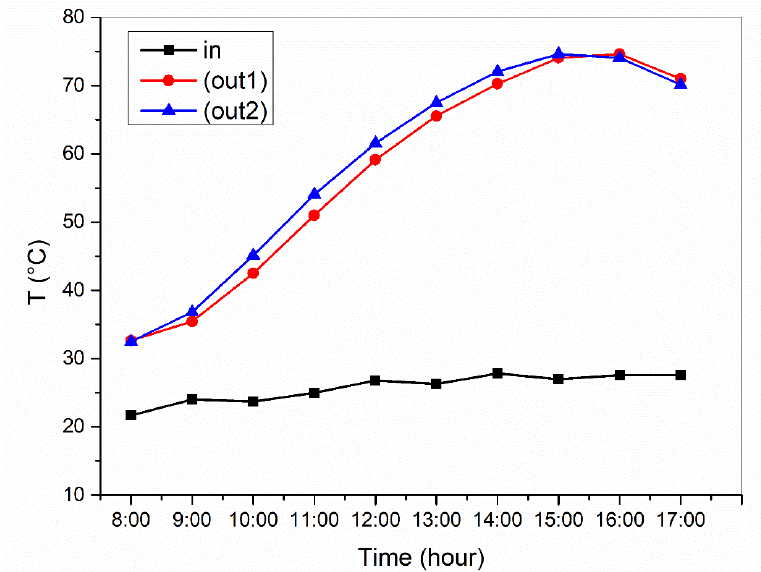
Figure 6: Temperature change during the day hours with coating measured at